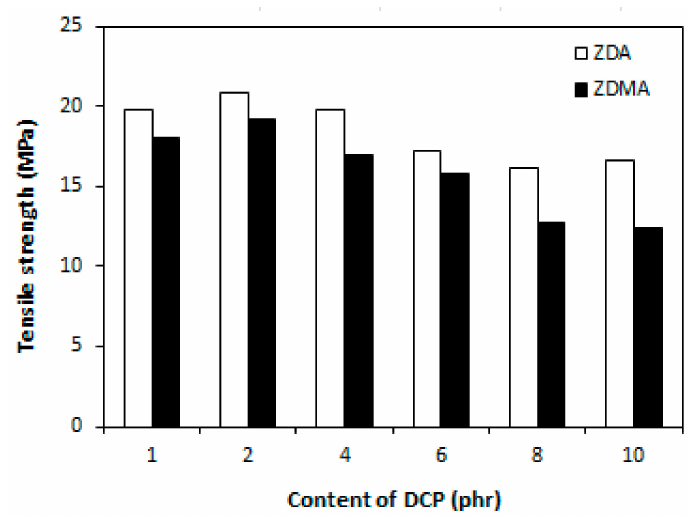
Figure 16. Influence of peroxide content on tensile strength of composites.